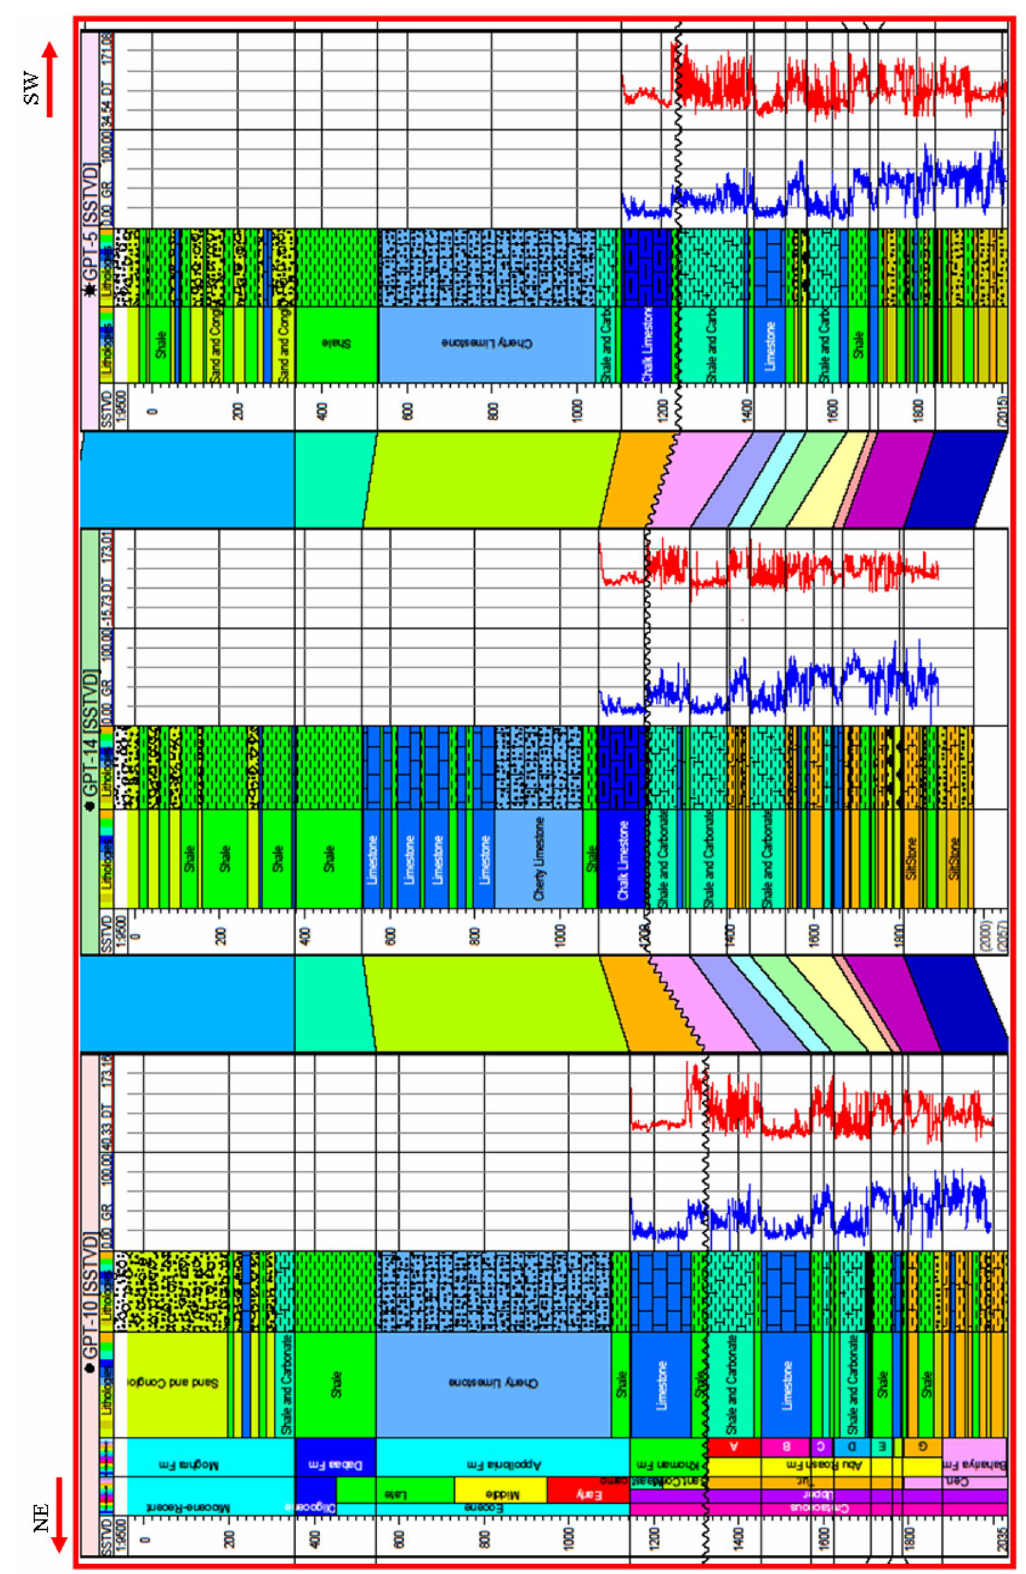
Fig. 4 Geologic cross section along the profile